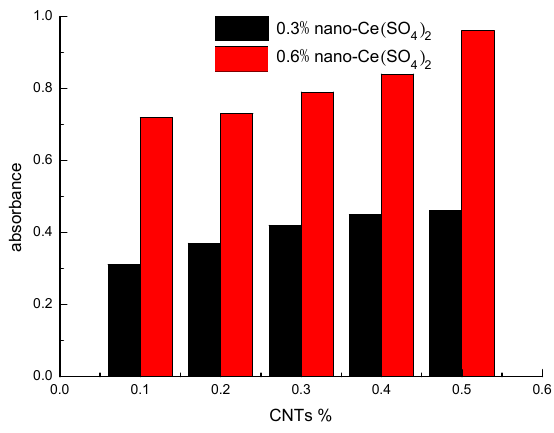
Figure 2. Absorbance of CNT dispersion.